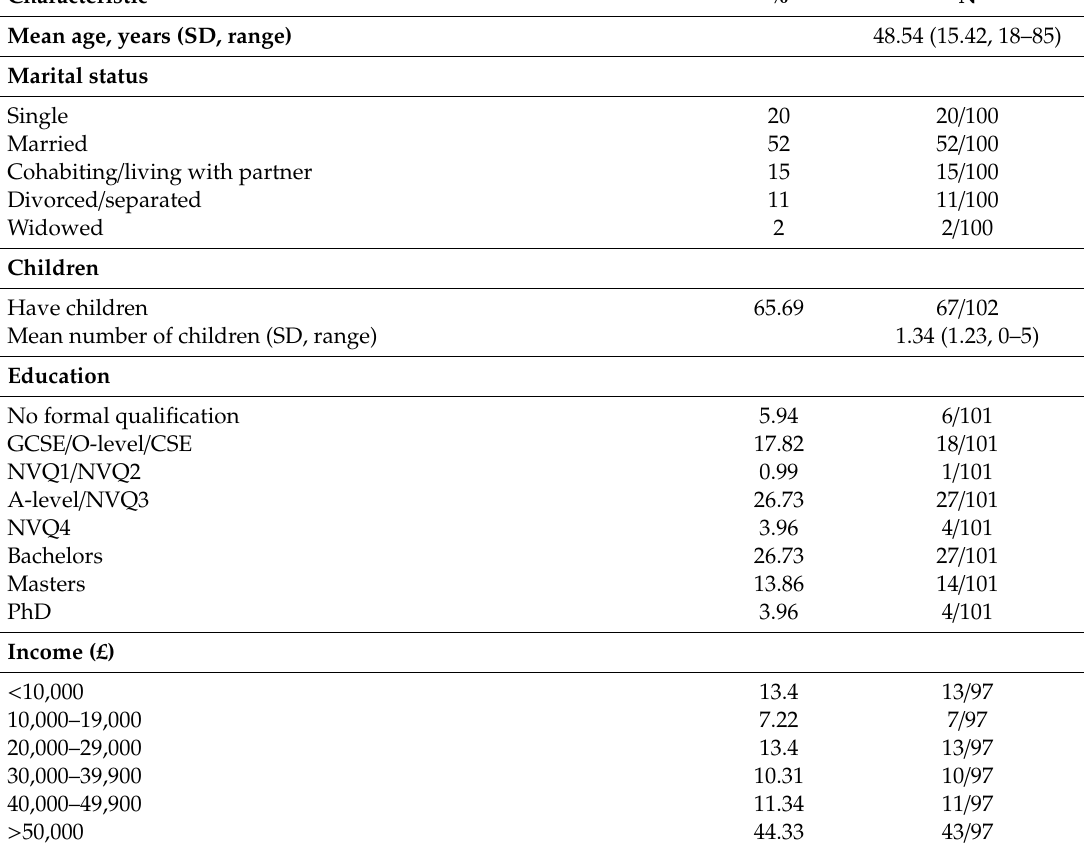
Table 1. Baseline characteristics of